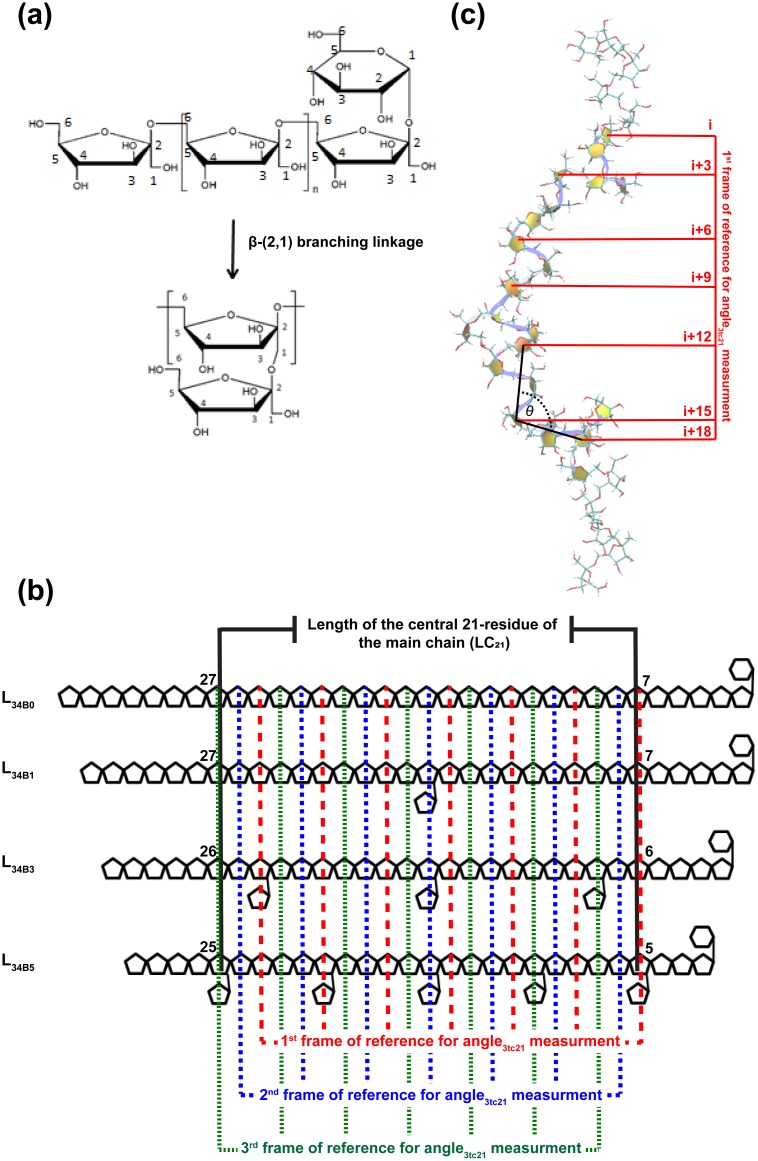
(a) Levan structure. (b) Simplified models of L34B0, L34B1, L34B3 and L34B5. LC21 and the first, second and third frames of reference for angle3tc21 measurement are also shown. (c) Example of angle3tc21 measurement for structure of L34B3, using the first frame of reference.